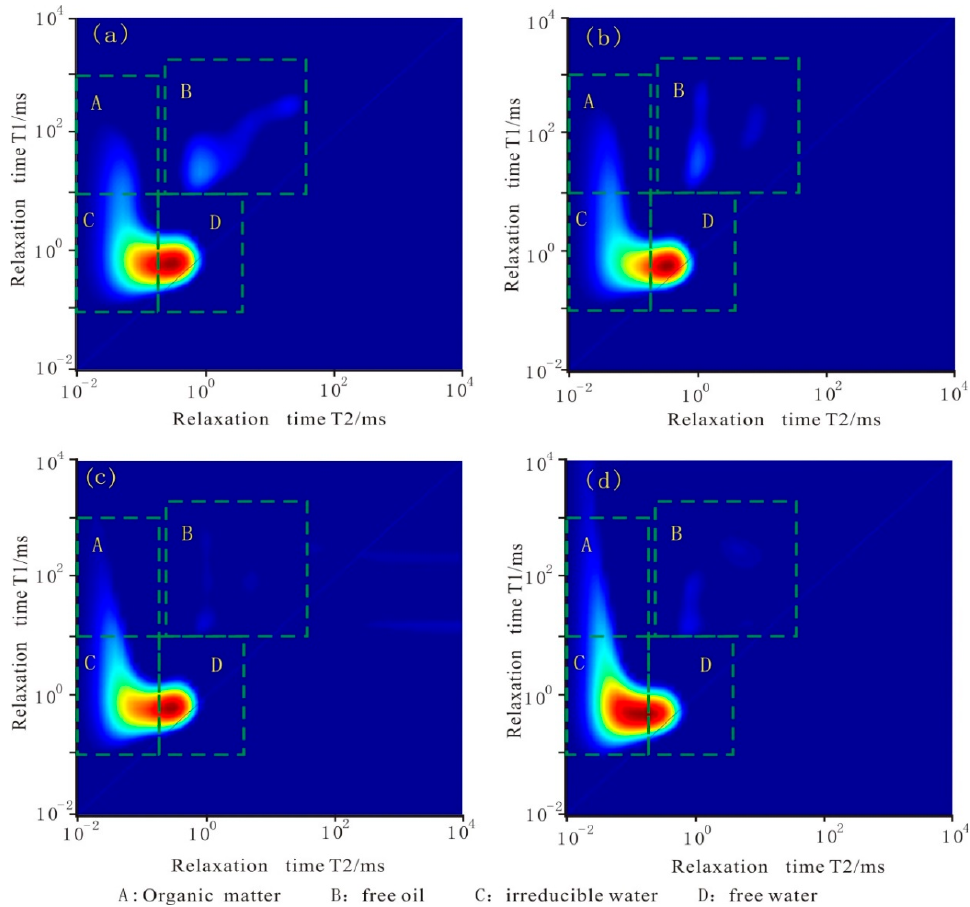
Figure 12. 2D NMR shale oil content analysis of different shale lithofacies in Es3. ( a ) Thin laminar shale, 4381 m; ( b ) thick laminar shale, 3895.6 m; ( c ) massive mudstone 4373.35 m; ( d ) argillaceous siltstone, 3992.5 m.